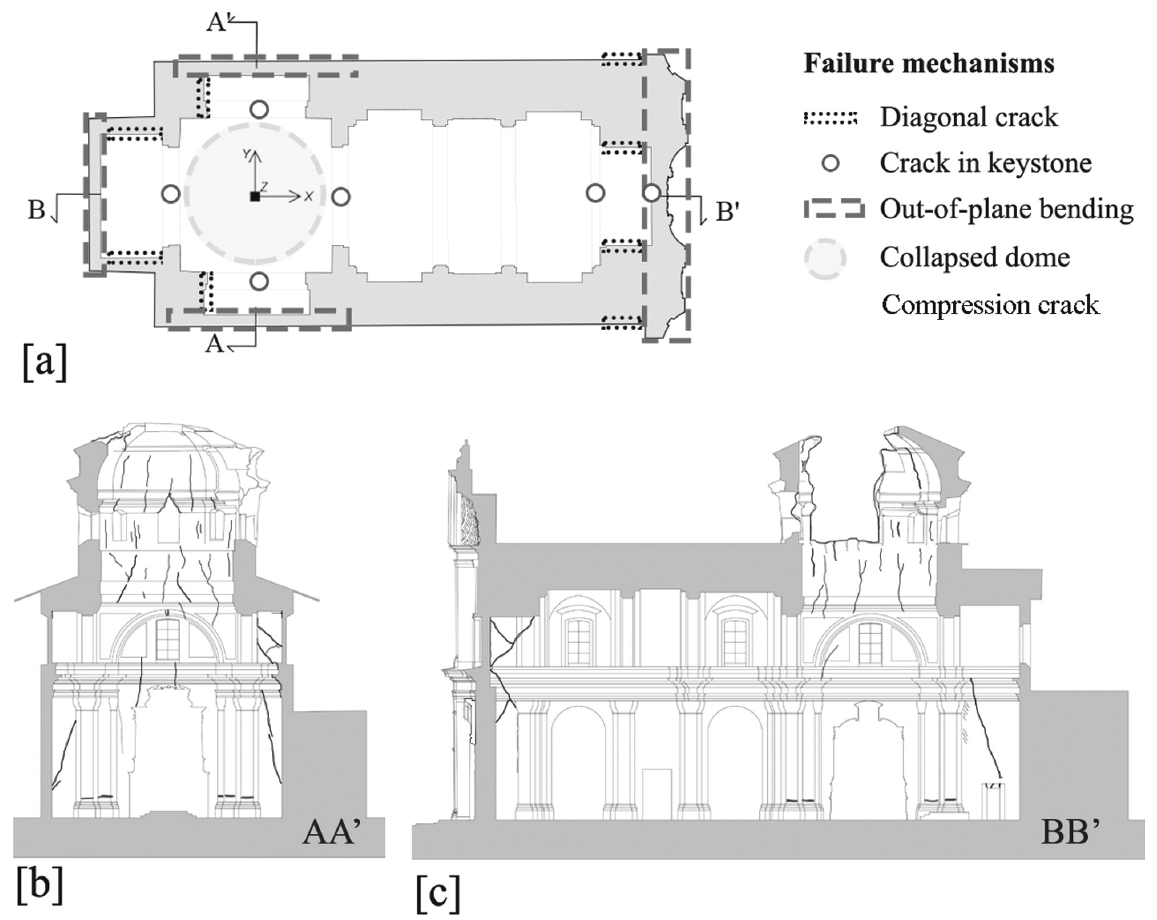
Figure 1. Some views of Anime Sante Church after the 2009 earthquake; plan scheme of the failure mechanisms (a), transverse (b) and lon- gitudinal (c) section with crack